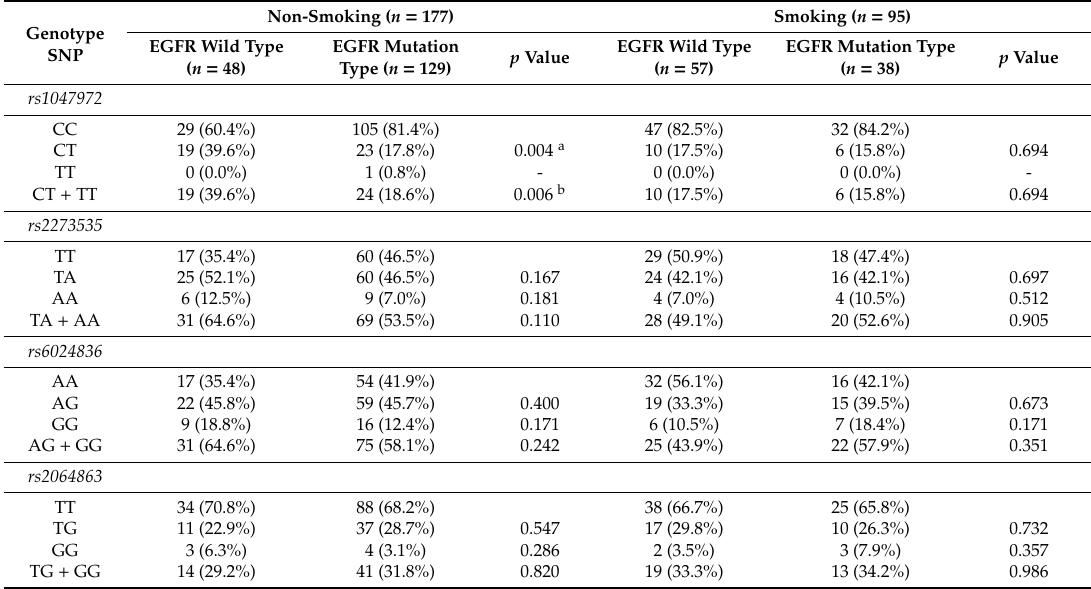
Table 4. Distribution frequency of AURKA genotypes of lung adenocarcinoma with di ff erent cigarette smoking status and epidermal growth factor receptor